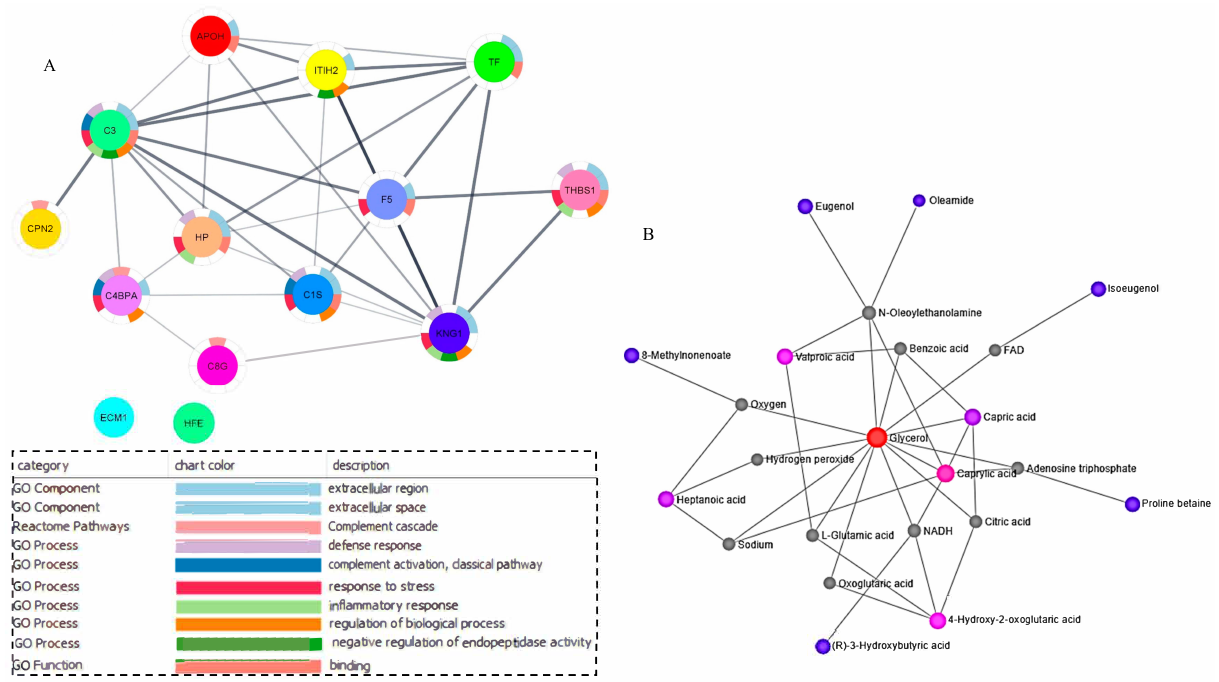
Figure 6. Networking analysis of the correlated proteins and metabolite features. ( A ) Networking analysis showed 12 correlated proteins to be interconnected with FDR-enriched ontologies. ( B ) Networking analysis showed 12 of 20 correlated metabolites, as well as BHB, to be interconnected. Other joining metabolites found in the network that were not found in our study were colored